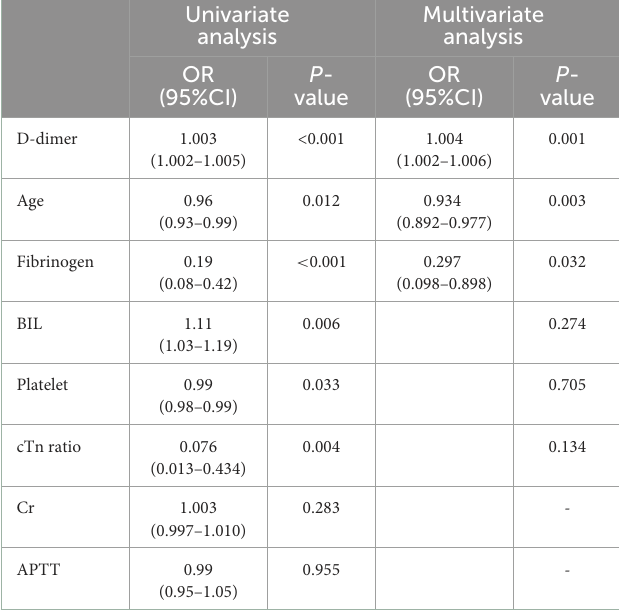
TABLE 2 Univariate and multivariate analysis for differential risk factors for AAS with chest onset < 2h in the cTn cohort. Univariate Multivariate analysis analysis